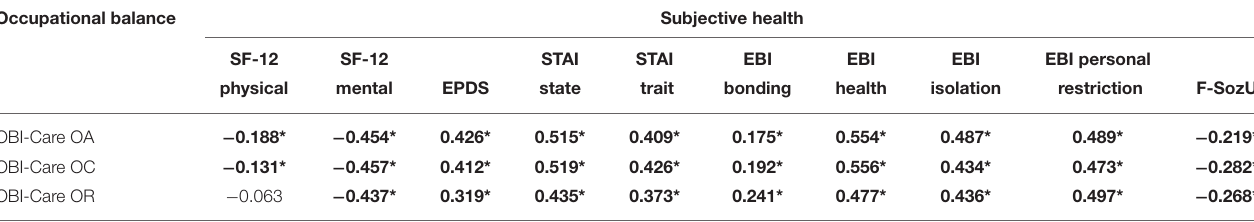
TABLE 2 | Spearman’s rank correlation coefficients occupational balance and subjective health. Occupational balance